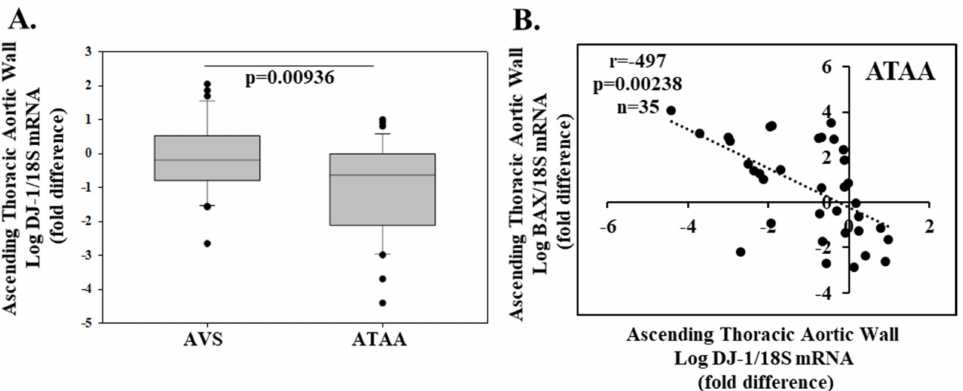
Figure 4. Aortic wall DJ-1 expression is decreased in patients with ascending thoracic aneurism. In a prospective study, 66 consecutive patients of whom 31 (18 male and 13 female; mean age 64.6 ± 11.5 years) with normal ascending thoracic aortic diameter underwent atrial valve replacement for severe aortic valve stenosis (AVS), and 35 patients (28 male and 7 female; mean age 65 ± 10.2 years) underwent replacement of an ascending thoracic aortic aneurysm (ATAA). The study was approved by the ethics committee of the University of Athens General Hospital Attikon, and informed consent was obtained from all patients. Biopsy-sized pieces of the aortic wall were collected from the greater curvature of the distal aortic root neighboring the anterolateral portion of the sino-tubular junction (ATAA). DJ-1, BAX, and 18S (housekeeping) gene expression was determined by real-time quantitative (RT-PCR). DJ-1/18S mRNA in ATAA was calculated as fold change over AVS and presented as box plots showing the median and interquartile range. p value shown ( A ). Negative correlation between pro-apoptotic BAX and DJ-1 in ATAA patients ( B